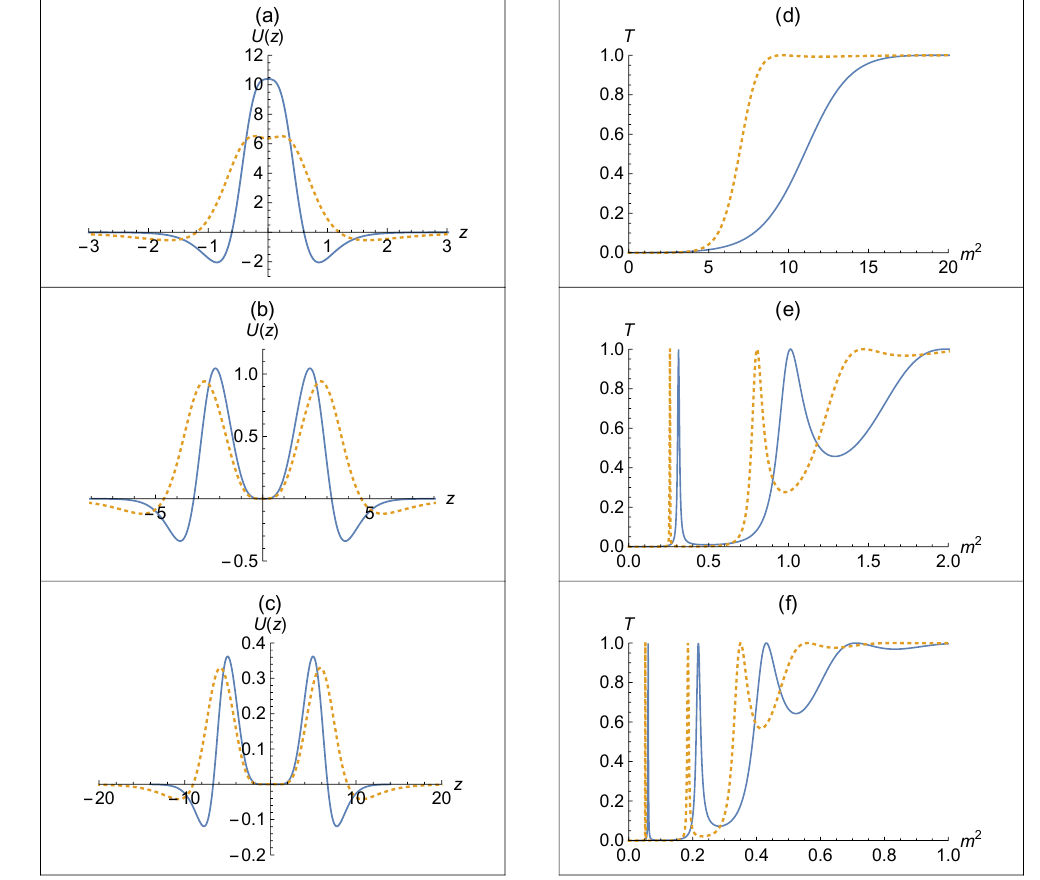
Figure 7 . Potentials U ( z ) and Transmission coe(cid:14)cient T ( m 2 ) for massive left fermions for D = 5 (line) and D = 10 (dotted), with (cid:17) = 1 and s = 1 (a, d), s = 3 (b, e) and s = 5 (c, f) in derivate dilaton